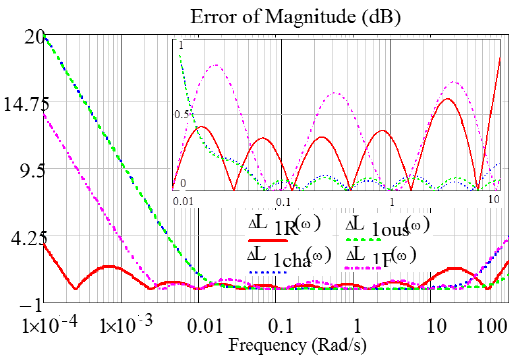
Fig. 10: Errors of the magnitude responses where: ∆ L 1 R ( ω ) - magnitude response error by RIM method; ∆ L 1 cha ( ω ) - magnitude response error by Charref’s method; ∆ L 1 ous ( ω ) - mag- nitude response error by Oustaloup’s method; ∆ L 1 F ( ω ) - magnitude response error by FIM.